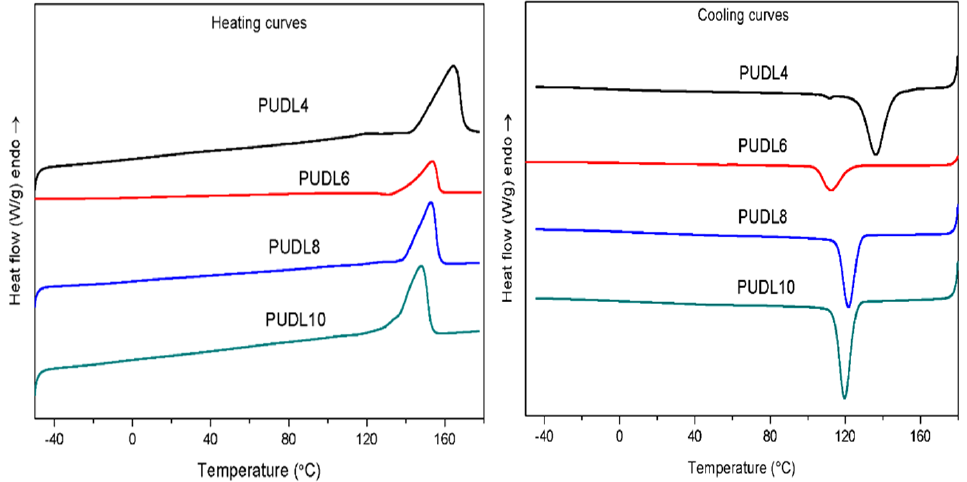
Figure 6. DSC heating scans ( left ) and cooling scans ( right ) of PUDL.